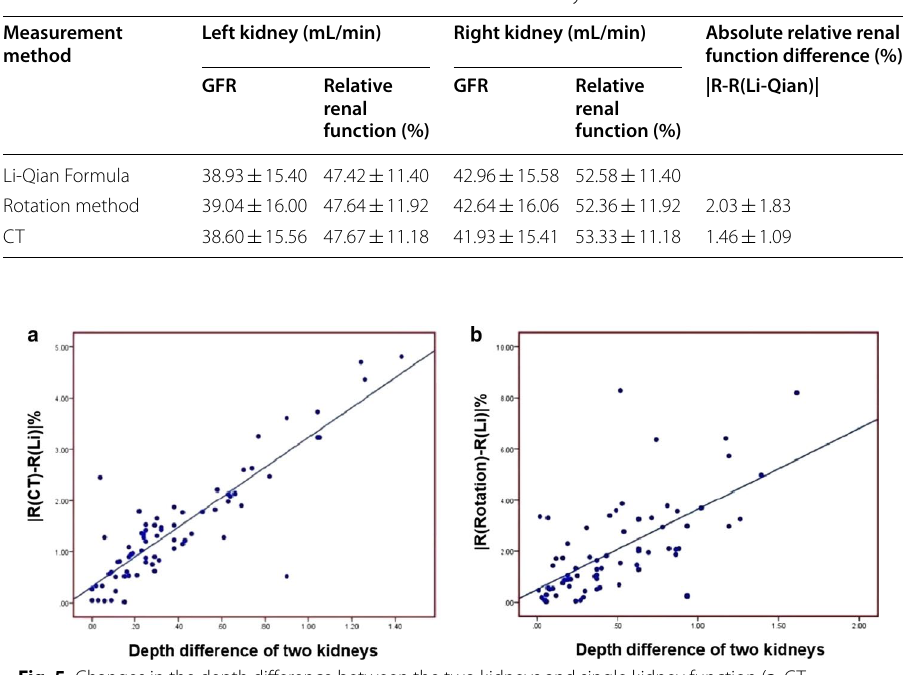
Fig. 5 Changes in the depth difference between the two kidneys and single kidney function ( a : CT— Li-Qian’s formula, b : rotation method—Li-Qian’s